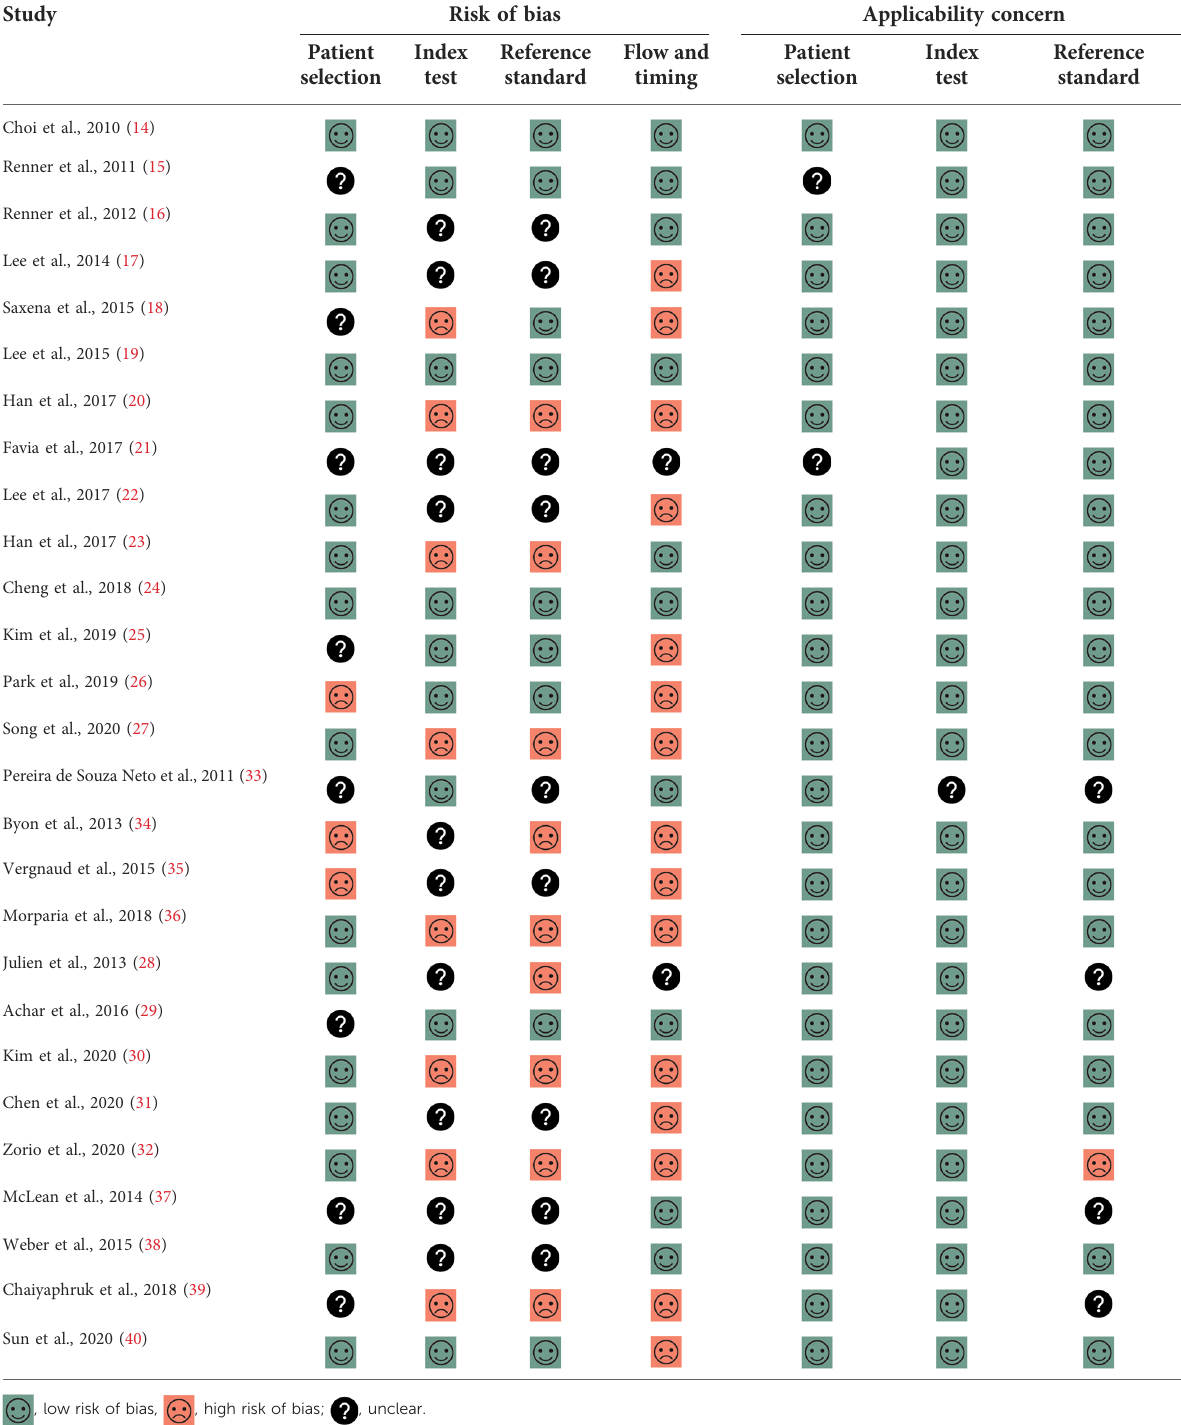
TABLE 2 Risk of bias